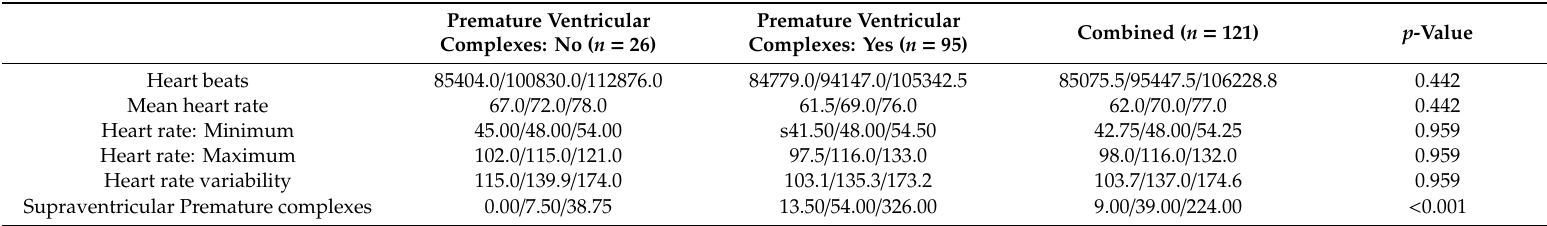
Table 2. Holter monitor variables according to presence / absence of PVCs. Data are Quartile I / median / Quartile III.